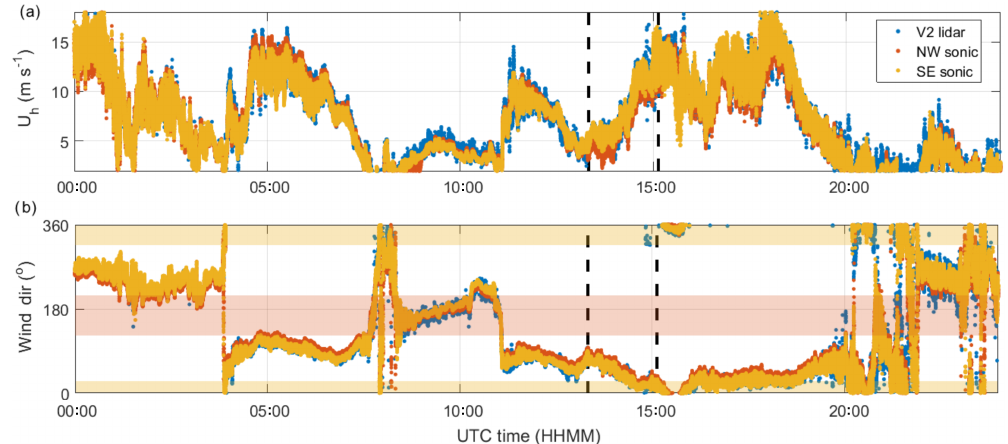
Figure 3. Wind velocity data acquired from sonic anemometers and lidar profiler at 150m height: (a) horizontal wind speed U h (ms − 1 ) ; (b) wind direction ( ◦ ). The date of the observation is 25 March 2015. Two vertical dashed lines represent the availability period of radar data.